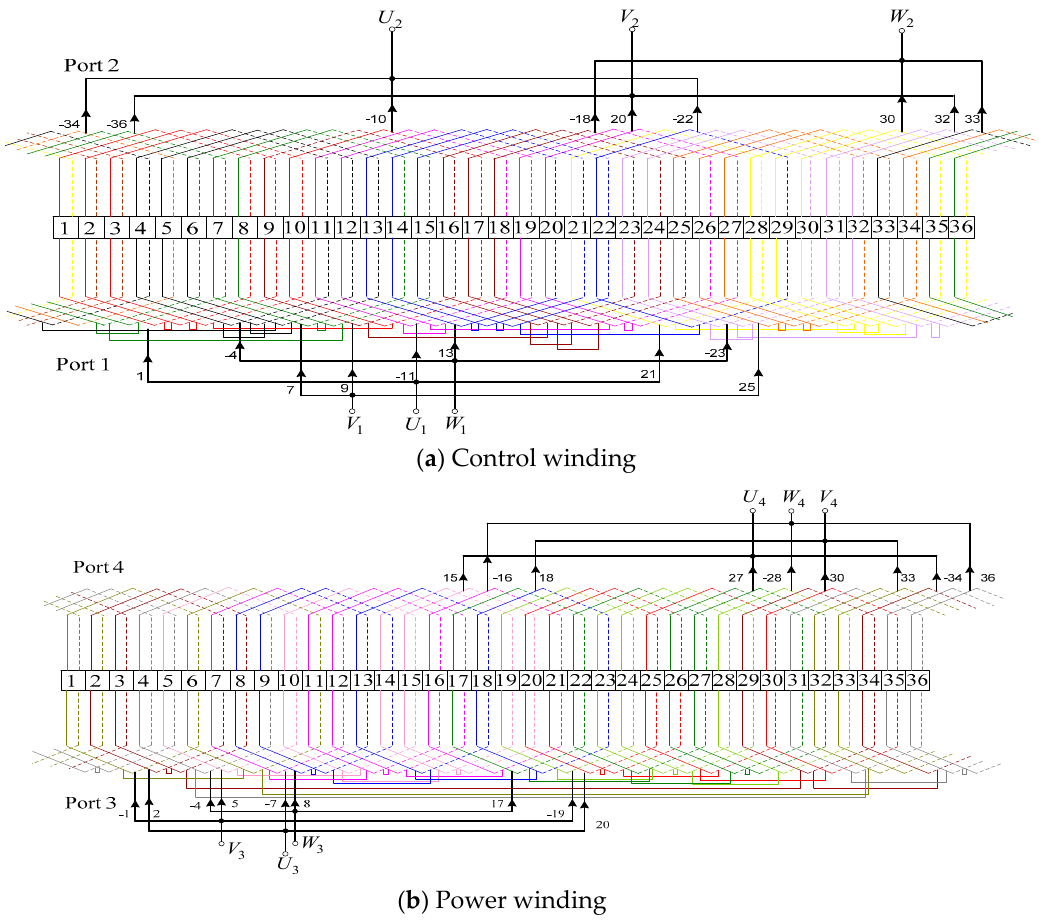
Figure 8. The wiring structure of the stator winding.